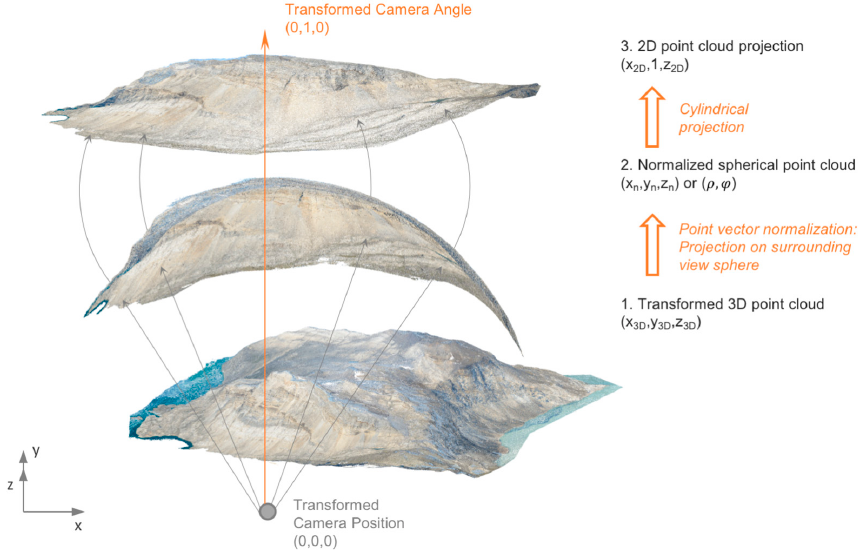
Figure 5. Schematic workflow of the point cloud transformation and projection to create a 2D image